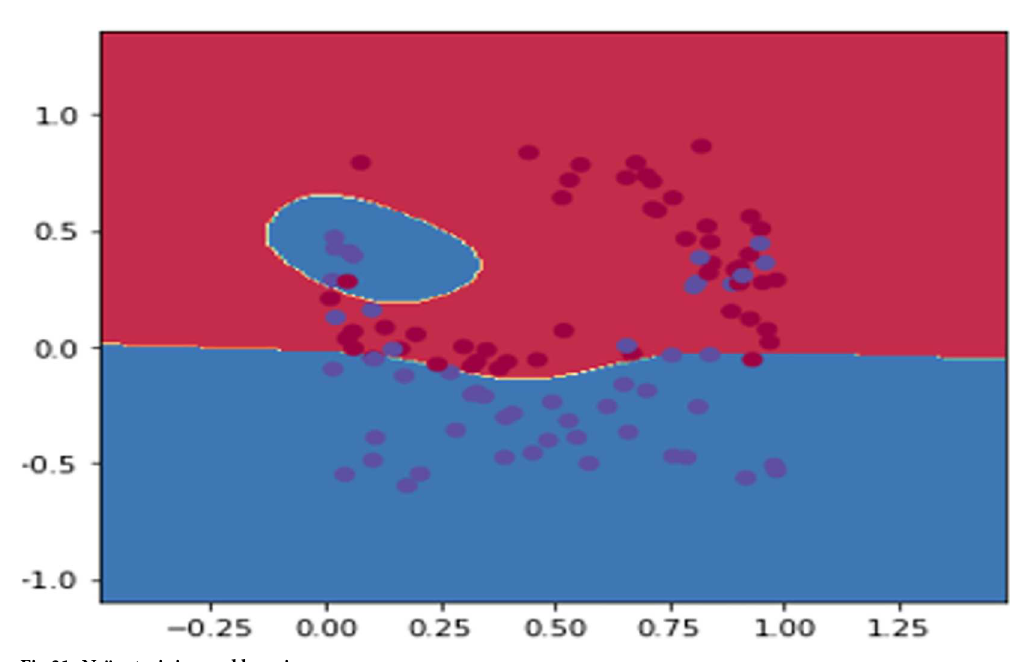
Fig 31. Na ï ve training and